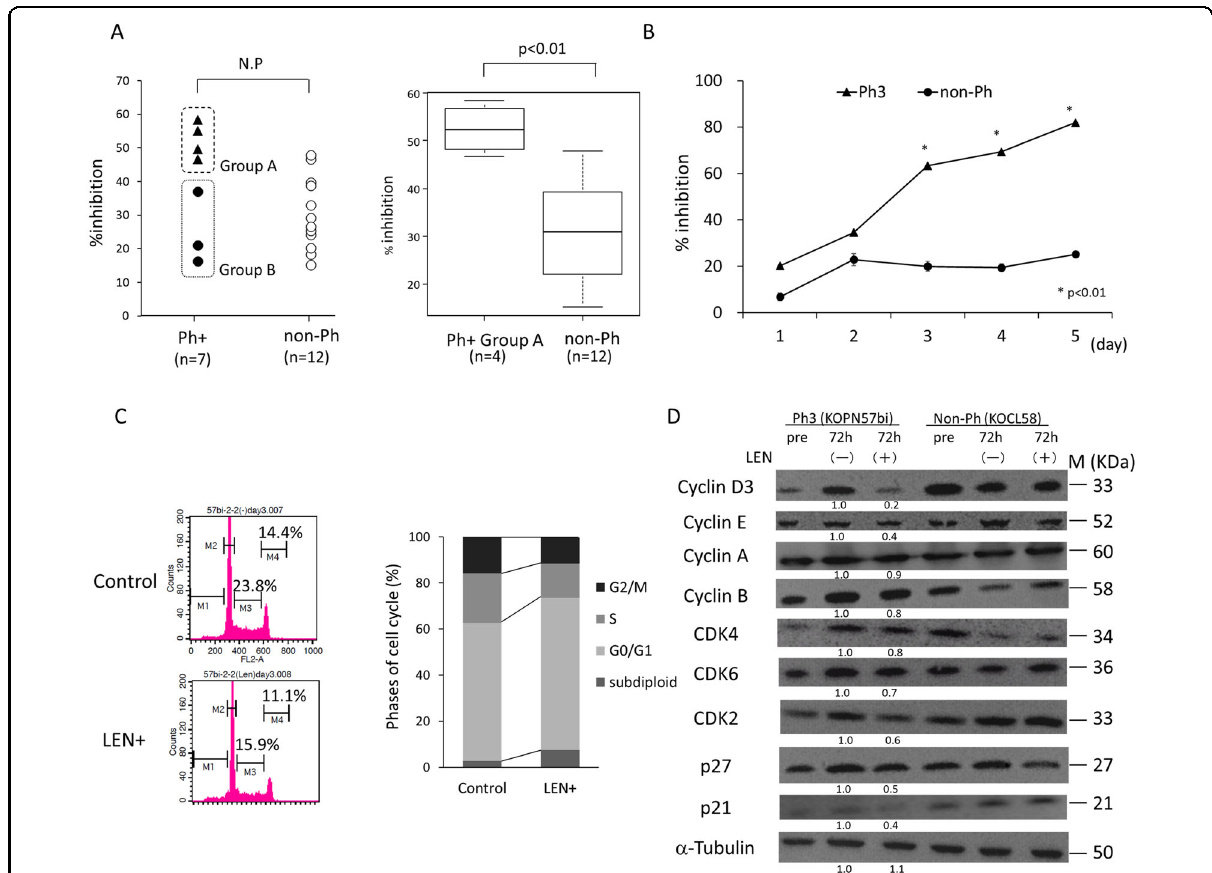
Fig. 2 Effects of LEN on B-cell leukemia cell lines. A Analysis of thymidine uptakes after LEN treatment. Seven Ph + and 12 non-Ph cell lines were cultured for 72 h in the presence or absence of 10 µM LEN, and % inhibitions of thymidine uptakes by LEN were compared by Mann – Whitney U test. Left panel: Comparison of % inhibitions between Ph + cell lines ( n = 7) including group A (closed triangles, n = 4) and group B (closed circles, n = 3) and non-Ph cell lines (open circles, n = 12). The % inhibition in group A Ph + cell lines ( n = 4, median 52.5%, range 46.7 – 58.3%) was signi fi cantly ( p < 0.01) greater than in non-Ph cell lines ( n = 12, median 30.4%, range 15.1 – 47.9%). Right panel: Comparison of % inhibition between Ph + group A ( n = 4) and non-Ph ( n = 12) cell lines. The results were shown as the box-and-whisker plots. B Time-course of % inhibition of thymidine uptakes in Ph + and non-Ph cell lines after LEN treatment. Ph3 (KOPN57bi) and non-Ph (KOPN63) cells were cultured in the presence or absence of 10 µM LEN, and thymidine uptake was measured at days 1, 2, 3, 4, and 5. P values were calculated by unpaired t -test. A signi fi cant difference in % inhibition was observed in Ph3 starting day 3 and thereafter. C Analysis of cell cycle progression after LEN treatment. KOPN57bi cells were cultured for 72 h in the presence or absence of 10 µM LEN and cell cycle progressions were analyzed by PI staining. Left panel: The representative fl ow cytogram showing a decrease in the S (M3) and G2/M (M4) phases in the presence of LEN. The X and Y axes indicate DNA content and cell numbers, respectively. Right panel: Experiments were performed 4 times. A signi fi cant decrease in the S (from 21.5 ± 3.0 % to 14.9 ± 2.2%, p < 0.002) and the G2/M (from 16.0 ± 5.4% to 11.2 ± 2.2%, p < 0.05) phases and a signi fi cant increase in the subdiploid region (from 2.8 ± 1.3% to 7.5 ± 4.4%, p < 0.05) were documented after LEN treatment. The G0/G1 phase was increased from 59.9 ± 8.4% to 66.1 ± 6.7%, after LEN treatment, but this difference was not signi fi cant. D Western blot analysis of changes in expression of CDKs, CDKIs, and cyclins after LEN treatment. KOPN57bi and non-Ph (KOCL58) cells were cultured for 72 h in the presence or absence of 10 µM LEN and expression of cell cycle regulators was examined on western blot. The bands were quanti fi ed by densitometry and shown as the relative to the control after compensation by α -tubulin expression. Primary antibodies were from Cell Signaling Technology (Beverly, MA) for cyclin B1, CDK6, and p27, from BD Bioscience (Franklin Lakes, NJ) for cyclin D3, cyclin E, CDK4, and p21, from Santa Cruz Biotechnology (Dallas, TX) for cyclin A, from BioLegend (San Diego, CA) for CDK2, and from SIGMA-Aldrich for α -tubulin. Expression of cyclins D3, E, and CDK2 was downregulated in the presence of